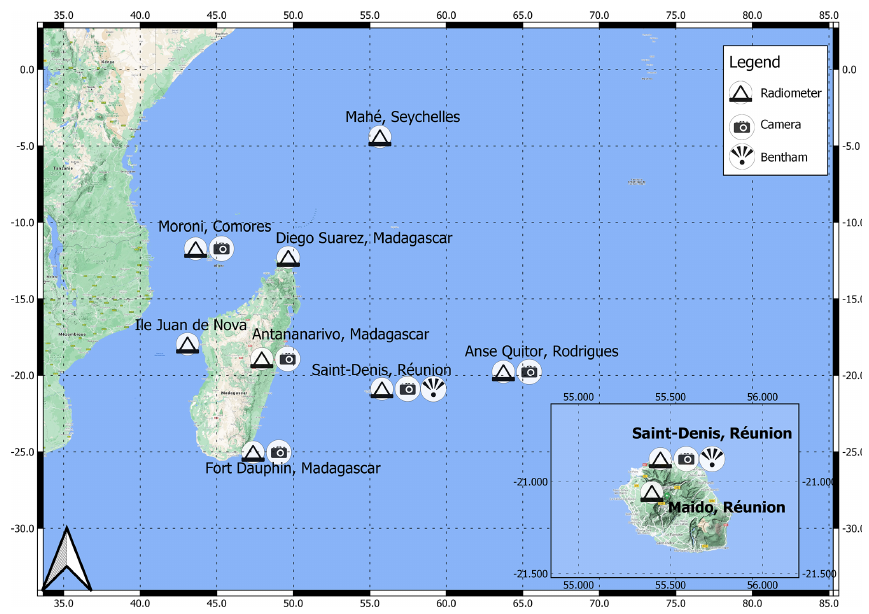
Figure 1. Location of the UV-Indien